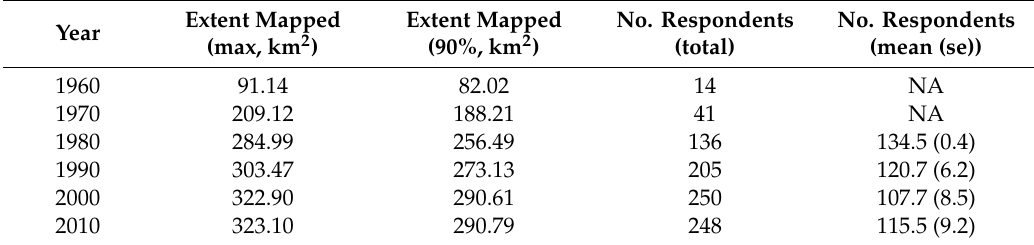
Table 1. Information about the maximum extent of fishing, the total number of respondents interviewed, and the mean number of respondents needed to reach the 90% area target in that year. Statistics only include information from samples that met the 90% area threshold; thus statistics from two earlier years (1960, 1970) are not included due to insu ffi cient sample